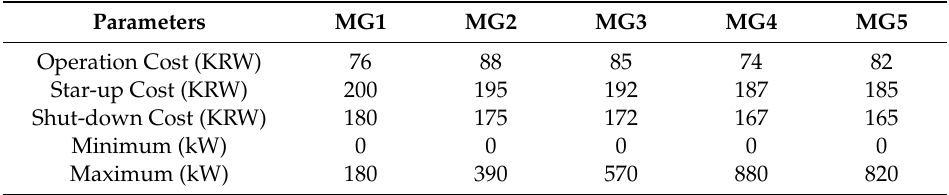
Table 1. Parameters related to dispatchable generators (DGs).